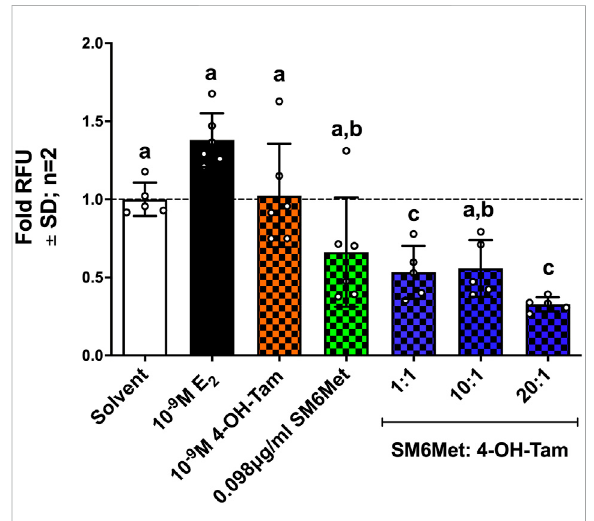
FIGURE 5 The combination of SM6Met with 4-OH-Tam is more effective than either alone at reducing the number of estrogen- induced invasive breastcancer cells. The number of invasive MCF- 7BUS cells was determined using the CytoSelectTM 96-Well cell invasion assay kit. The effects of 4-OH-Tam and SM6Met alone and in combination (1:1, 10:1 and 20:1) on the number of invasive breast cancer cells in the presence of 10 − 9 M E 2 is shown. The dotted line through the bars represents the solvent, which was set to one. Average ± SD is of two independent biological experiments done in triplicate. Statistical analysis was performed using One-way ANOVA with Tukey ’ s multiple comparisons test as post-test, where different letters indicate statistically signi fi cant differences at p < 0.05. Bars with common letters are not signi fi cantly